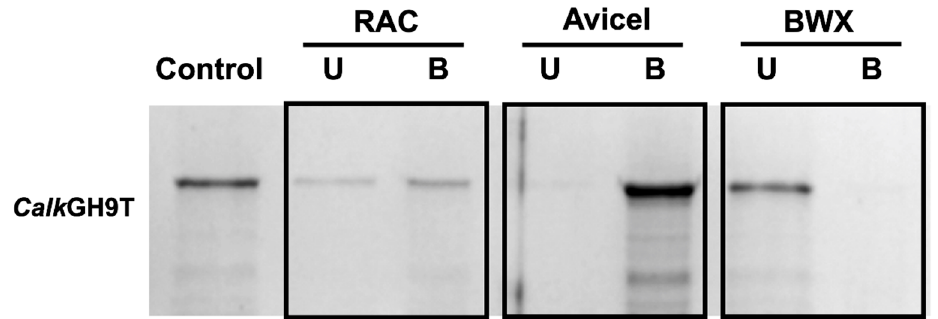
Figure 7. Binding ability of Calk GH9T to RAC, Avicel, and BWX. U and B refer to unbound and bound proteins, respectively.